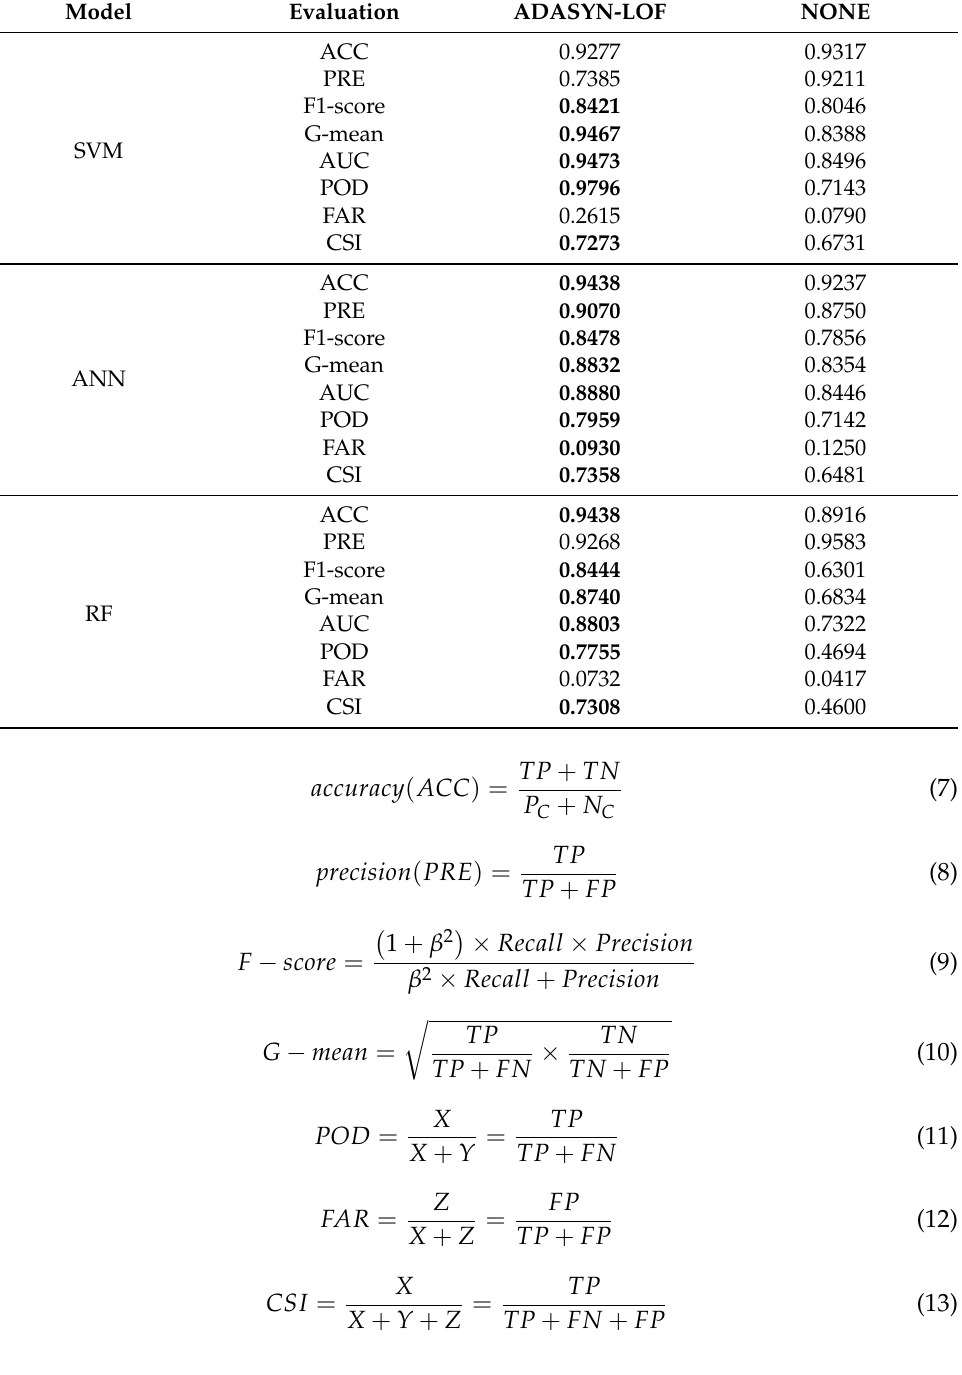
Table 3. The performance of different